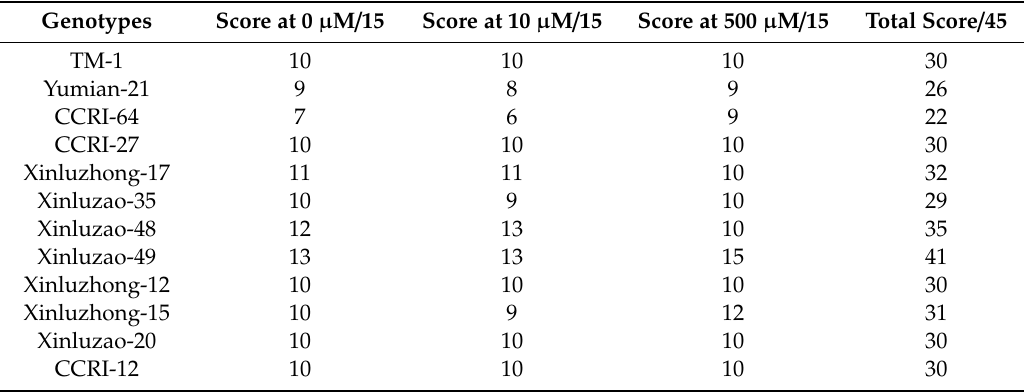
Table 11. Scoring of genotypes grown at P starvation (P; 0 µ M KH 2 PO 4 ), P deficient (P; 10 µ M KH 2 PO 4 )